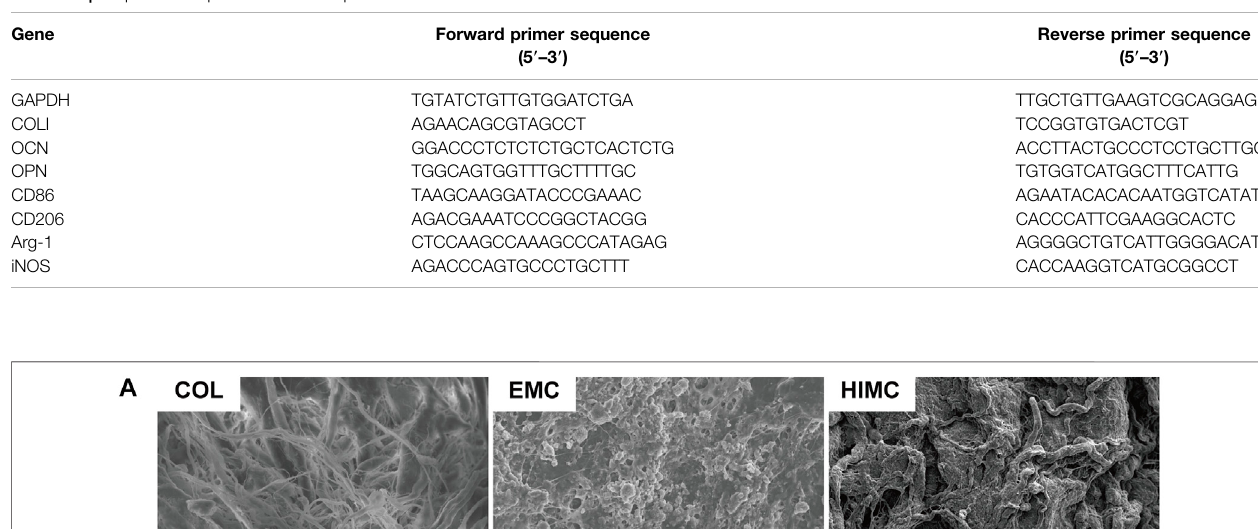
TABLE 1 | Sequences of primers used for qRT-PCR.